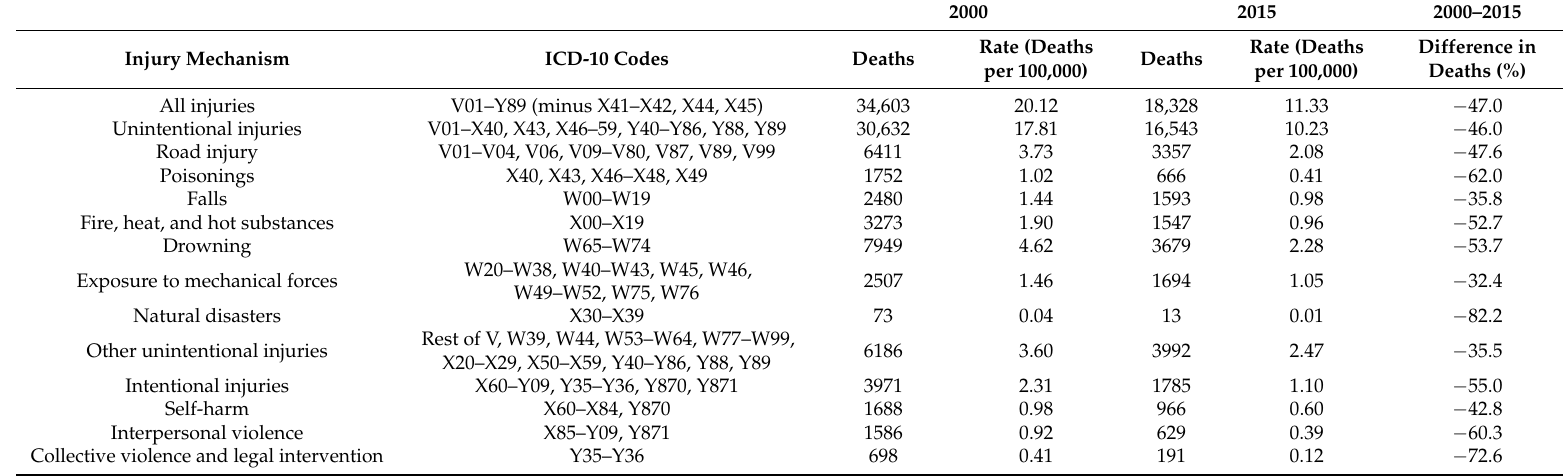
Table 1. Percentage change the in number of deaths in children under 15 years of age by injury mechanism in 2000 and 2015 for WHO European